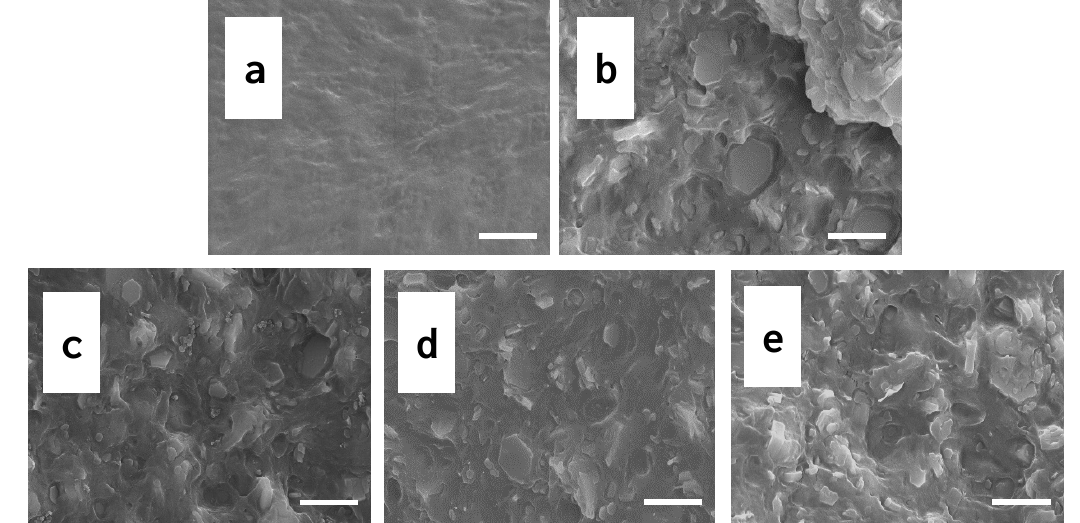
Figure 9. SEM micrographs of the brittle-fractured surface of EVA and its composites: ( a ) pure EVA, ( b ) EM, ( c ) EMCB, ( d ) EMCN, ( e ) EMCG. (Scale bar = 2 µ m).